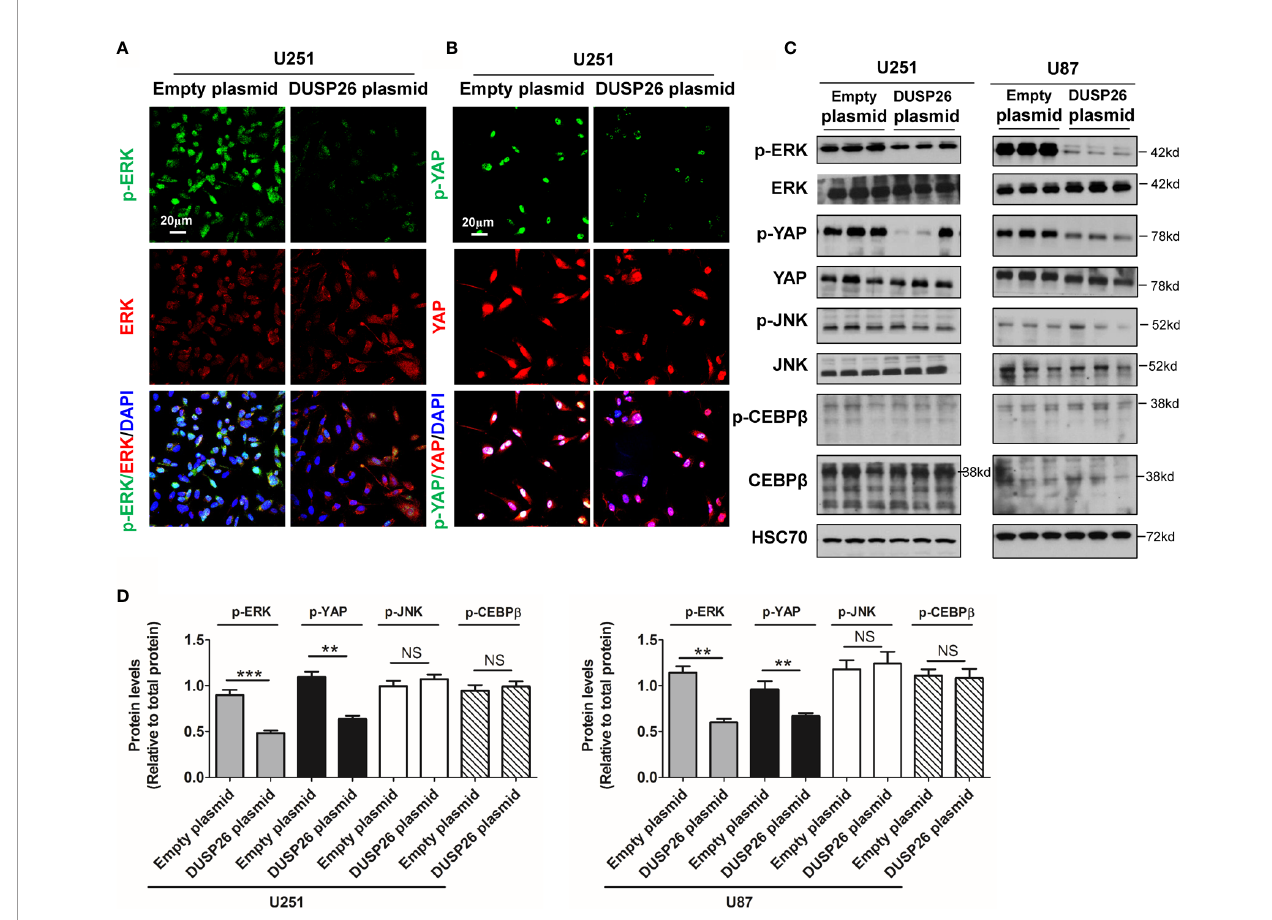
FIGURE 6 | Effect of DUSP26 overexpression on the MAPK signaling pathway. (A) Representative images of immuno fl uorescence based detection of p-ERK (green), ERK (red) in U251 cells transfected with empty vector or DUSP26 expression plasmid, cells were analyzed 48 h after transfection, and nuclei (blue) were counterstained with DAPI. (B) Representative images of immuno fl uorescence based detection of p-YAP (green), YAP (red) in U251 cells transfected with empty vector or DUSP26 expression plasmid and processed as described under (A) . (C) Representative images of western blots showing levels of p-ERK (Thr202/Tyr204), ERK, p-YAP (Ser127), YAP, p-JNK (Thr183/Tyr185), JNK, p-CEBPb (Thr235), and CEBPb in lysates of U251 or U87 cells transfected with empty vector or DUSP26 plasmid construct, cells were lysed 48 h after transfection and analyzed in triplicate, HSC70 was used as loading control. (D) Quanti fi cation of the western blots depicted in (C) . **p < 0.01; ***p < 0.001 and NS, denotes non-signi fi